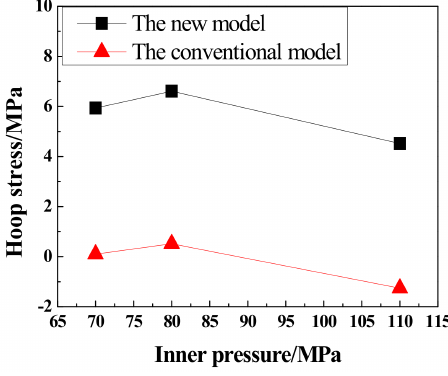
Figure 8. Hoop stress of cement sheath vs. inner